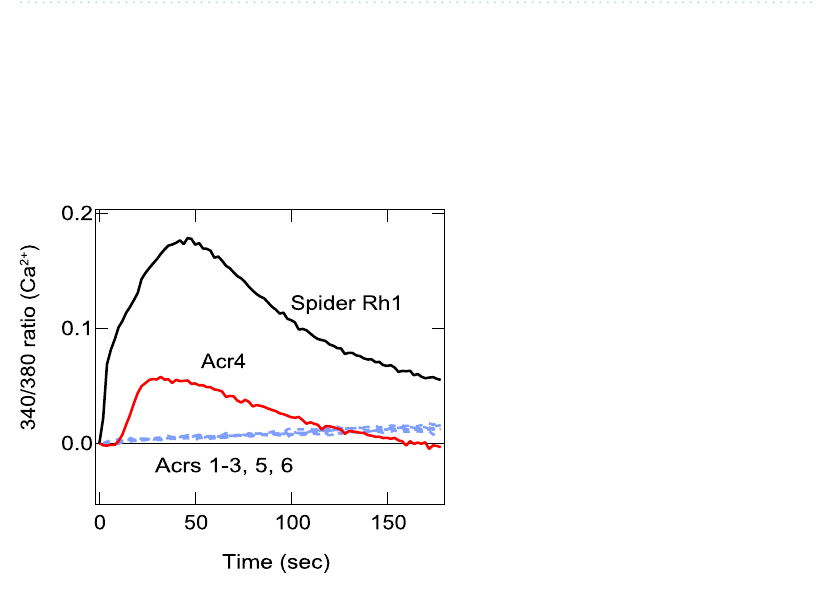
Figure 4. Intracellular calcium increase in the cultured cells expressing acropsins. Light-induced Ca 2+ increases in the cultured cells expressing each acropsin or jumping spider Rh1 were determined by using the Ca 2+ fluorescent indicator dye Fura-2. The excitation UV light for Fura-2 was used to stimulate the cells expressing each opsin during the measurement. Note that acropsin 4 (Acr4) elevates Ca 2+ by a UV light-dependent